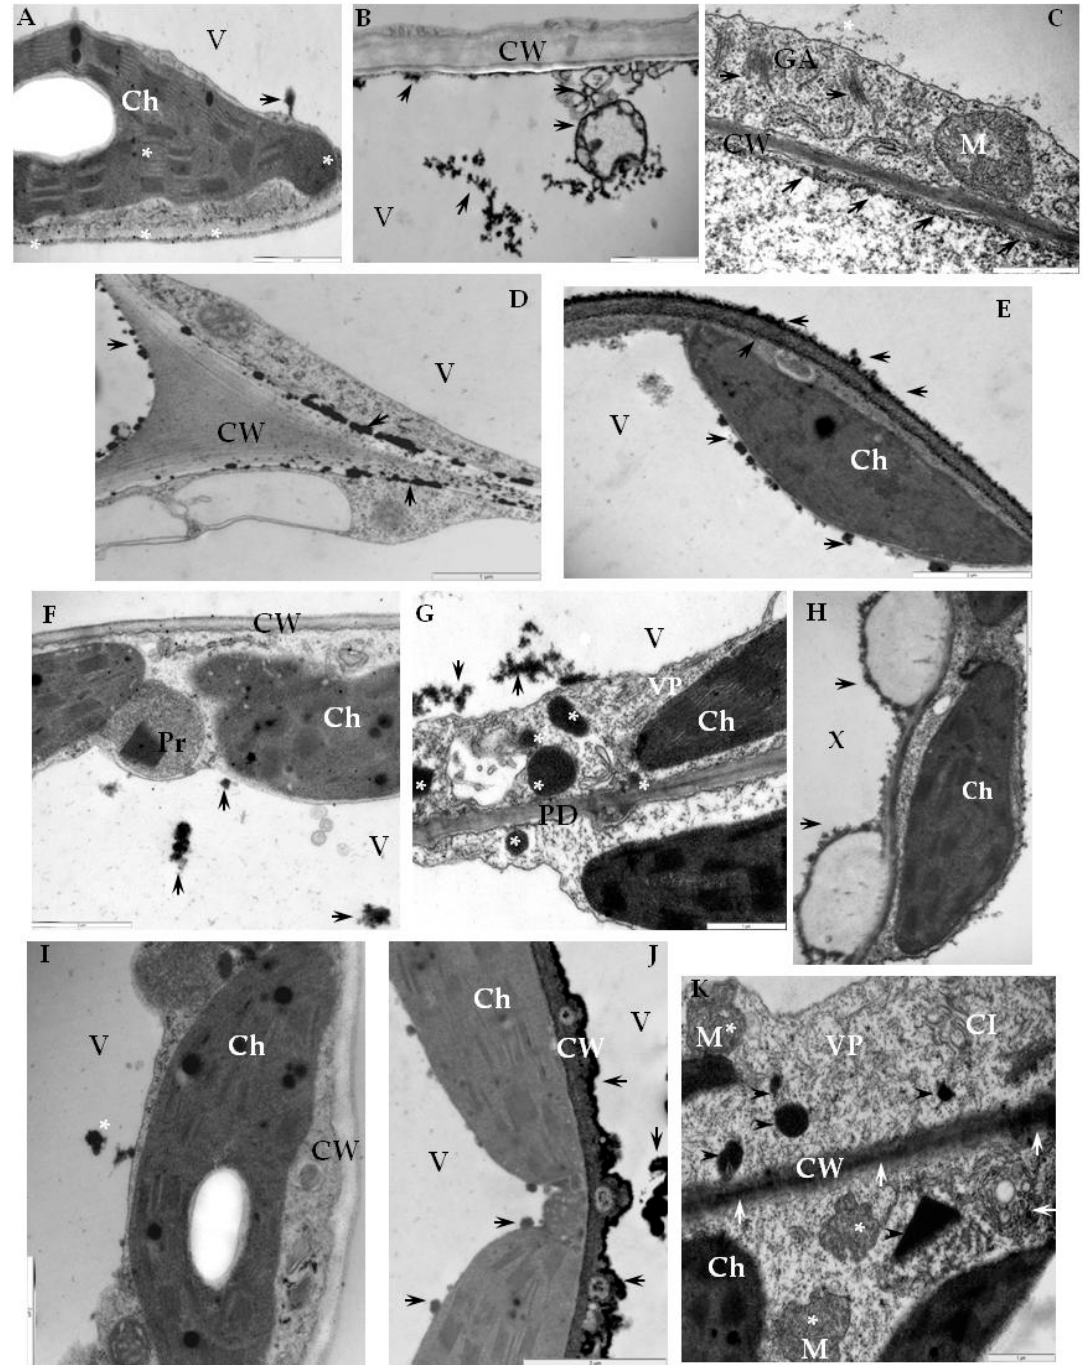
Figure 7. Ultrastructural detection of H 2 O 2 in an incompatible (B–E, G–H) and compatible (J,K) interactions of potato with PVY NTN . ( A ) H 2 O 2 deposits (*) along the cell wall in the vacuole (arrow) and of mock-inoculated Sárpo Mira leaf (control). Bar 2µm. ( B ) H 2 O 2 deposits (arrows) in stained membranous, vesicular structures inside the vacuole 1 day after PVY NTN -inoculation of potato Sárpo Mira. Bar 1µm. ( C ) Electron dense deposits of cerium perhydroxide precipitate along with the Golgi apparatus, along the cell wall and in the vacuole 1 day after PVY NTN -inoculation in mesophyll cell potato Sárpo Mira. Bar 1µm. ( D ) H 2 O 2 deposits (arrows) between the cell wall and plasmalemma and along the cell wall 7 days after PVY inoculation of potato Sárpo Mira mesophyll cell. Bar 1µm. ( E ) H 2 O 2 along cell wall and in vacuole along tonoplast (arrows) of a mesophyll cell 7 days after PVY NTN inoculation of potato Sárpo Mira mesophyll cell. Bar 2µm. ( F ) H 2 O 2 in the vacuole in mock-inoculated